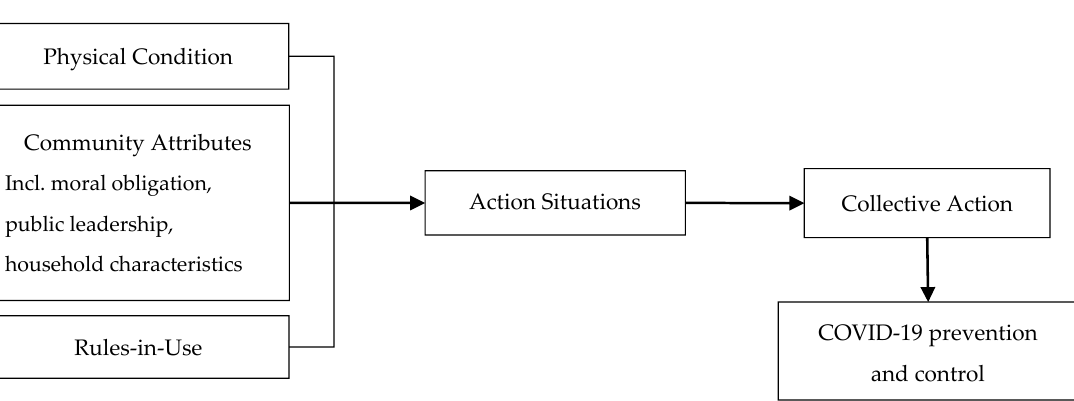
Figure 1. Theoretical framework to analyze the influential factors of collective action for epidemic prevention and control. Source: Adapted from Ostrom [39].